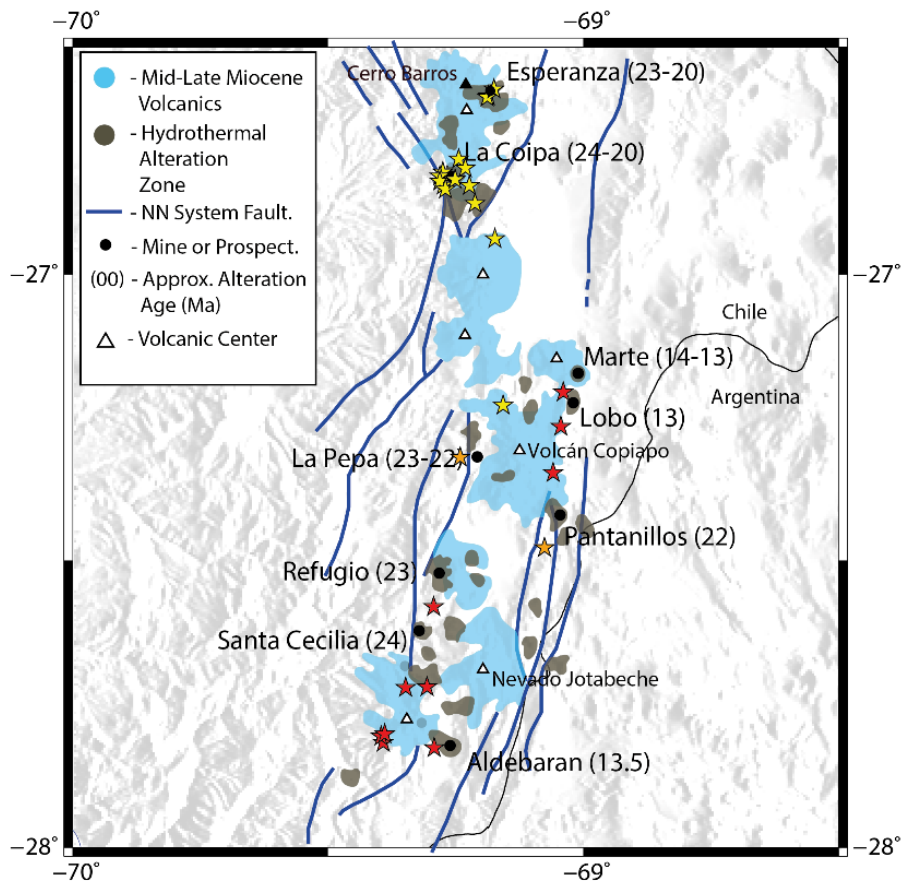
Figure 2. Location of alteration centers in the Maricunga Belt, northern Chile. The approximate ages of the main alteration-mineralization are shown as Ma. Hydrothermal alteration and Middle-Late Miocene volcanic zones are represented with gray and light blue shadows, respectively. Selected local innominate (NN) fault systems are represented with blue lines. Volcanic complexes are shown as white triangles. (Modified from [4]). The spatial distribution of gold deposits is indicated with yellow, orange, and red stars to represent high-sulphidation Au-Ag epithermal, transitional, and porphyry Au-Cu type deposits, respectively [2].